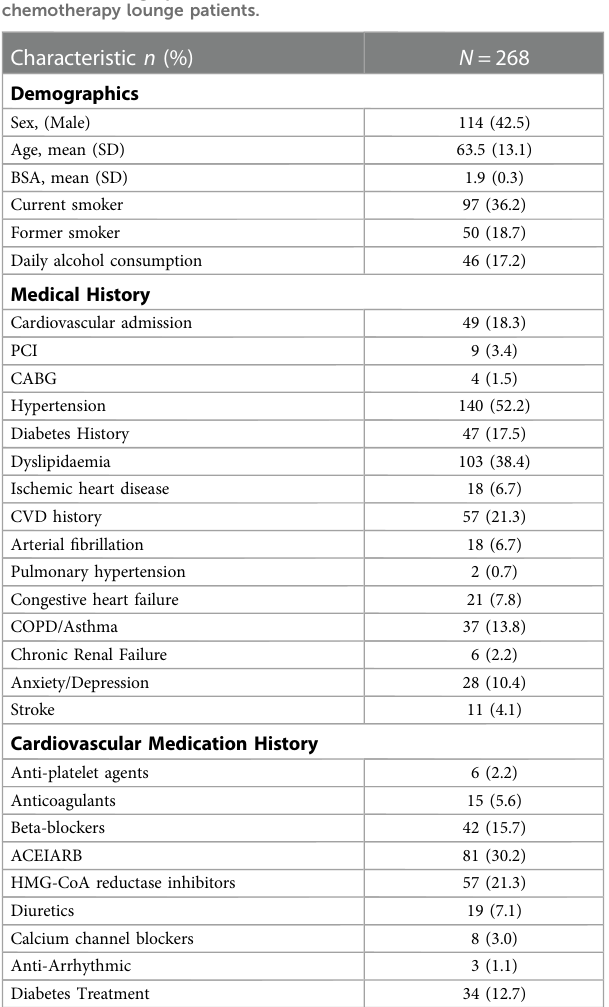
TABLE 1 Demographic and cardiovascular characteristics of the chemotherapy lounge